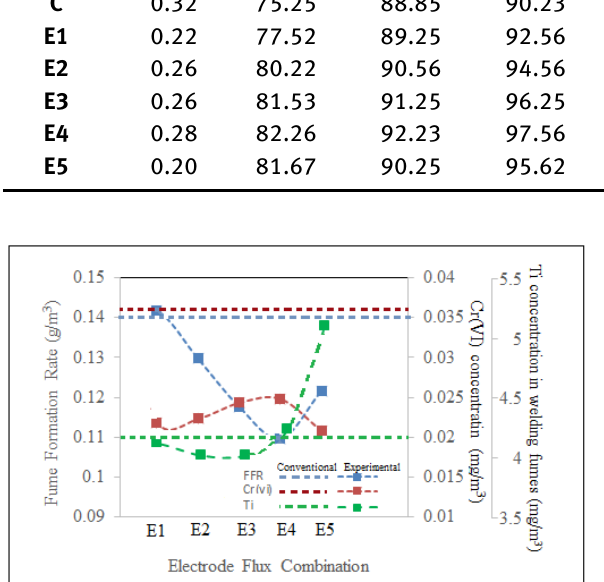
Figure 2: FFR and Cr(VI) concentration